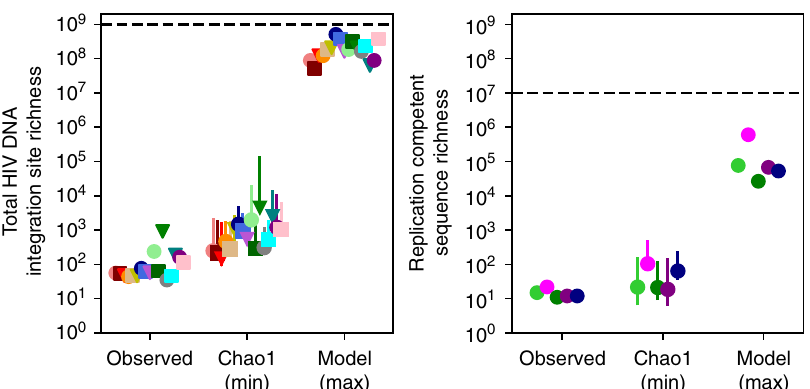
Fig. 3 Observations underestimate the number of distinct HIV sequences during ART. Observed sequence richness underestimates the true HIV sequence richness. For both data sources, Chao1 provides an estimate of the lower bound (min) of true sequence richness (error bars are asymmetric con fi dence intervals, see Supplementary Methods). In all cases, Chao1 estimates are above observed values. Our conservative modeling technique estimates a much higher upper bound (max) for true sequence richness. Nevertheless, the total HIV sequence population size (dashed lines: 10 9 for total HIV DNA and 10 7 for replication-competent HIV) is 1 – 2 orders of magnitude above the upper bound estimates for sequence richness, suggesting substantial clonality of HIV sequences. All marker colors correspond to data in Fig. 2a and